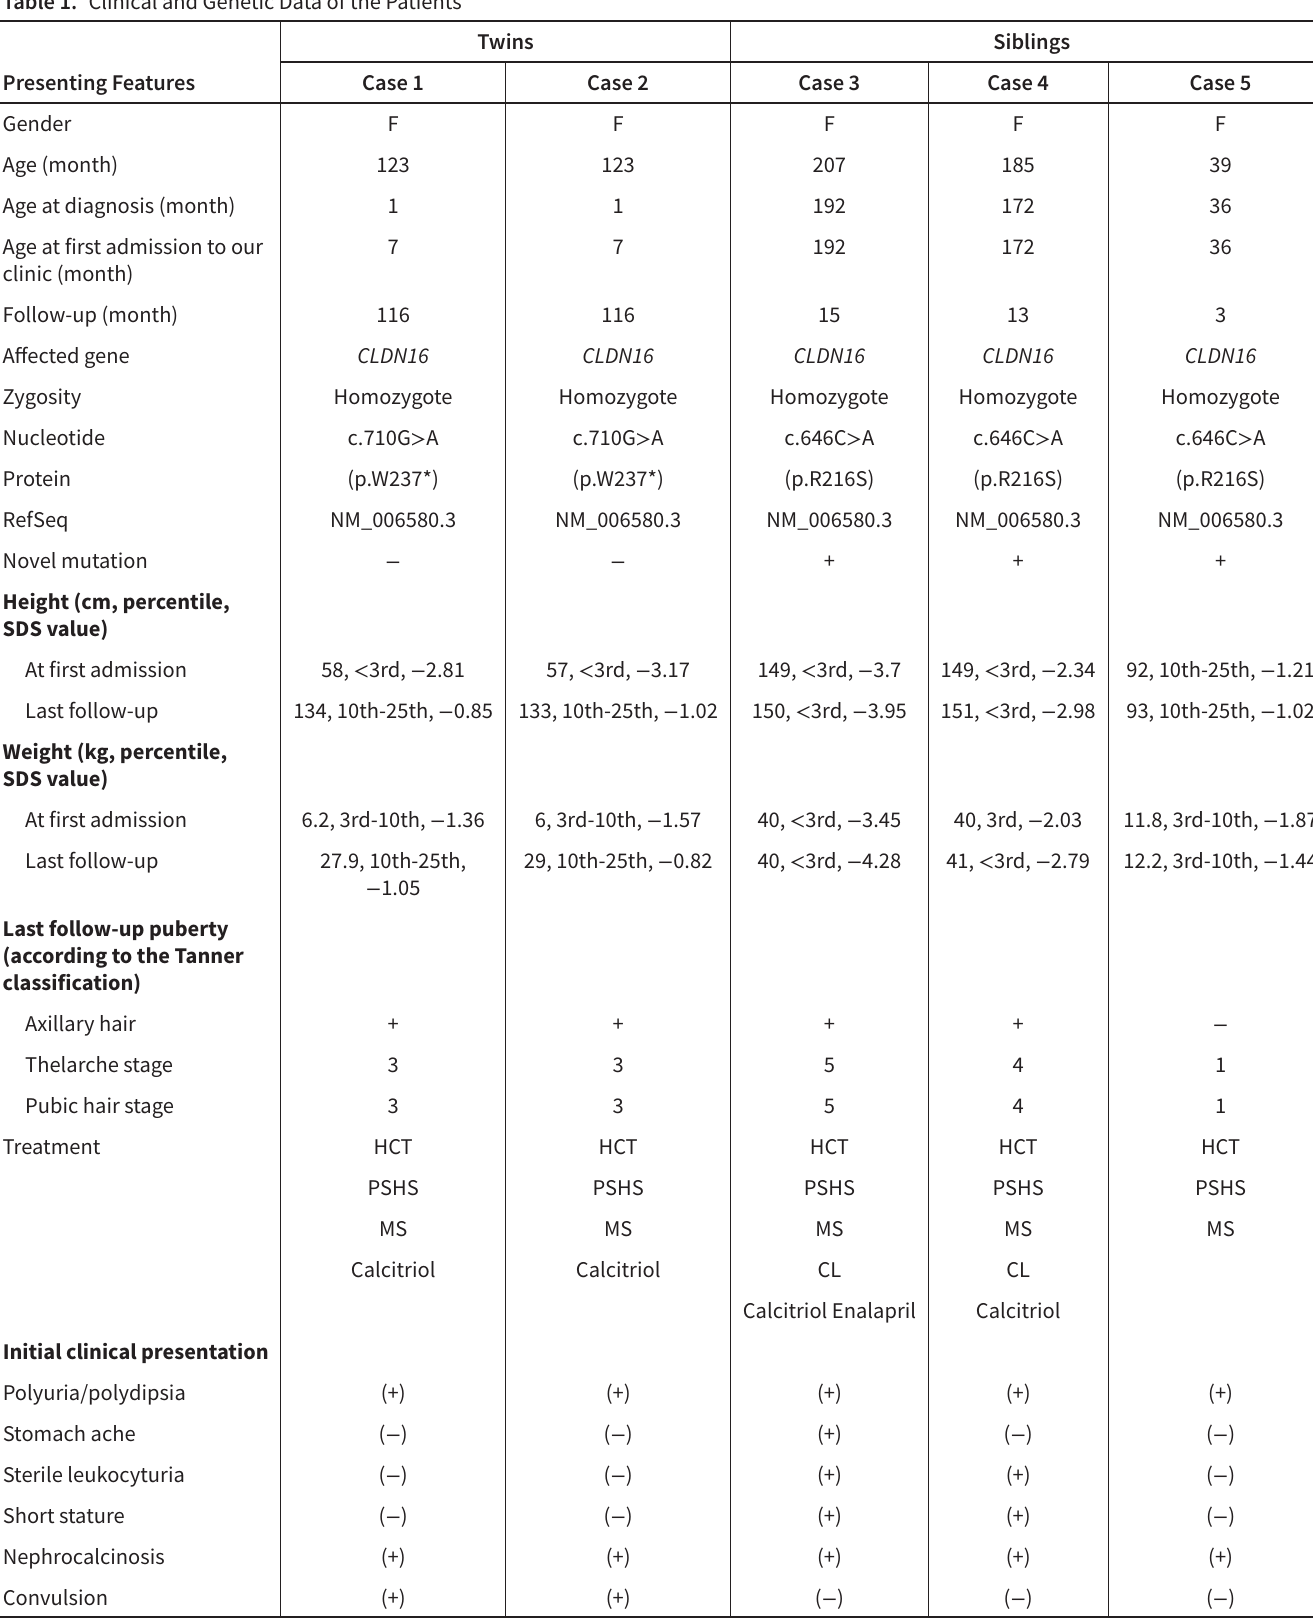
Table 1. Clinical and Genetic Data of the Patients